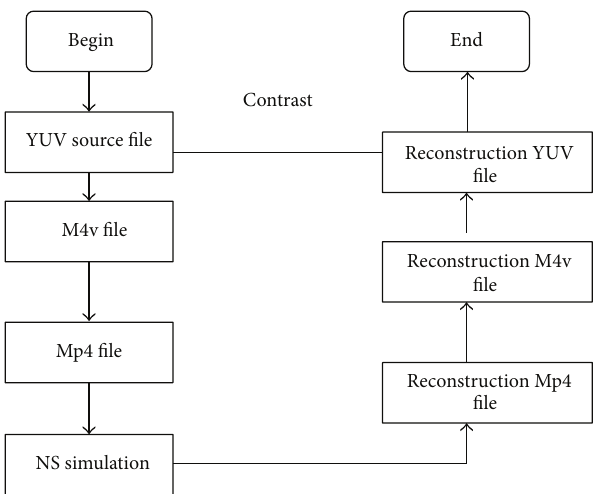
Figure 1: Image transmission quality evaluation process.